Question: Which visualization type does this figure use?
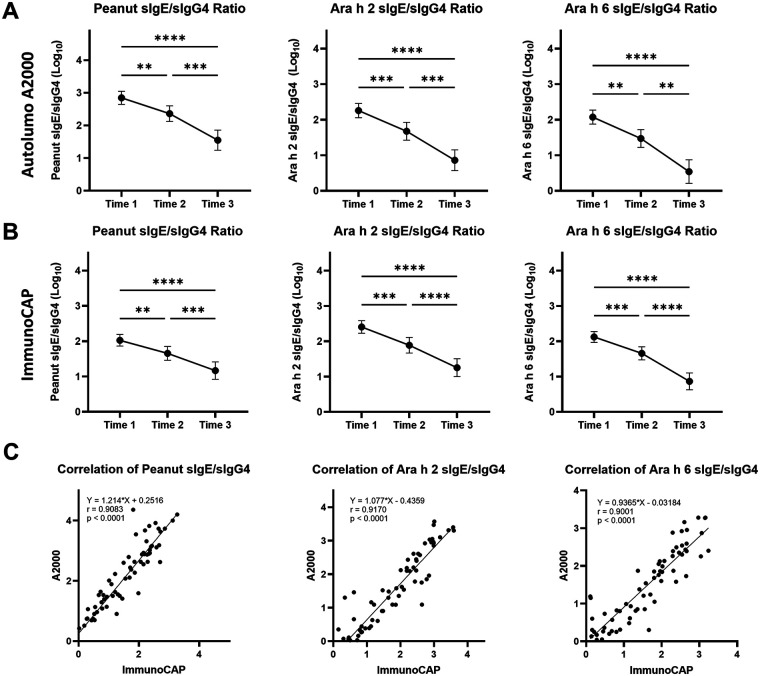
Answer: scatter